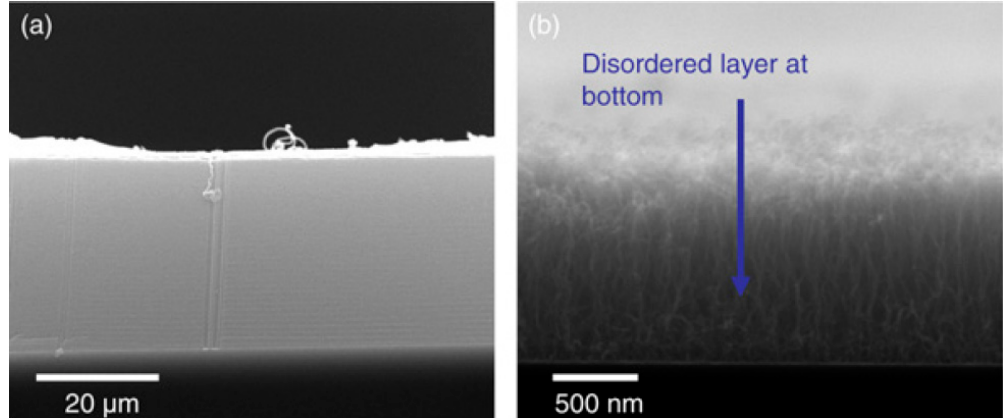
Figure 9. SEM micrographs of VACNT on ( a ) Al 2 O 3 DBL/Fe catalyst or ( b ) TiN DBL/Fe catalyst. ( a ) highly dense and well-aligned compared to ( b ) highly disordered VACNT morphology. Reprinted with permission from Amama, Carbon; Ref. [85] copyright 2012, Elsevier.